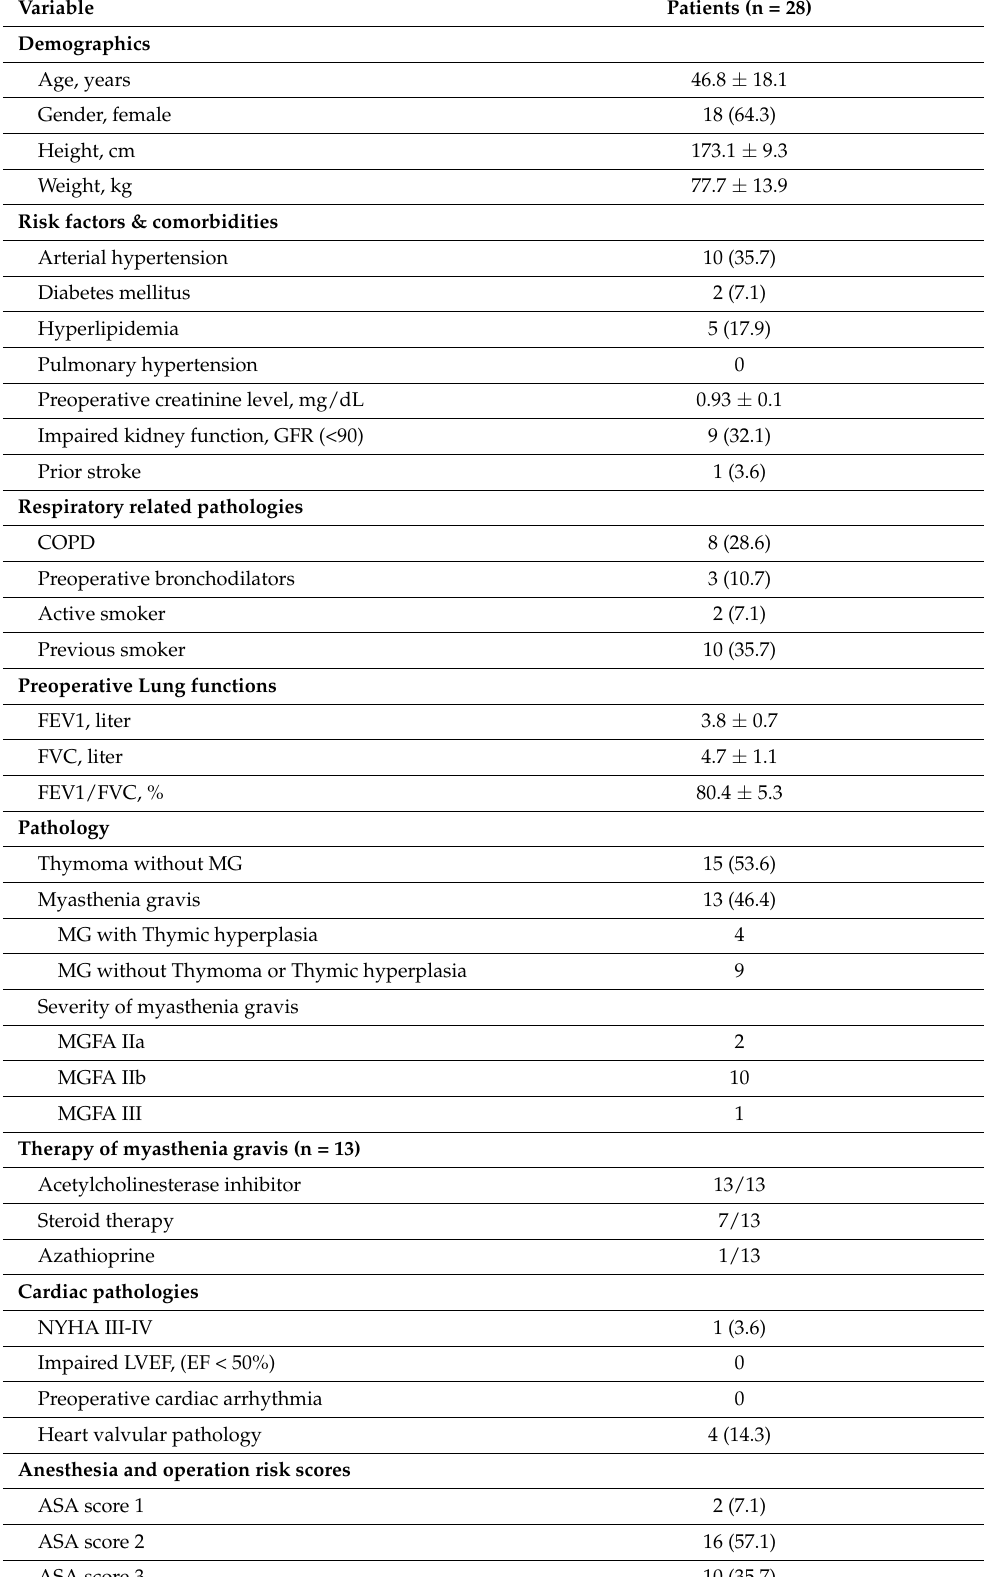
Table 1. Preoperative demographic